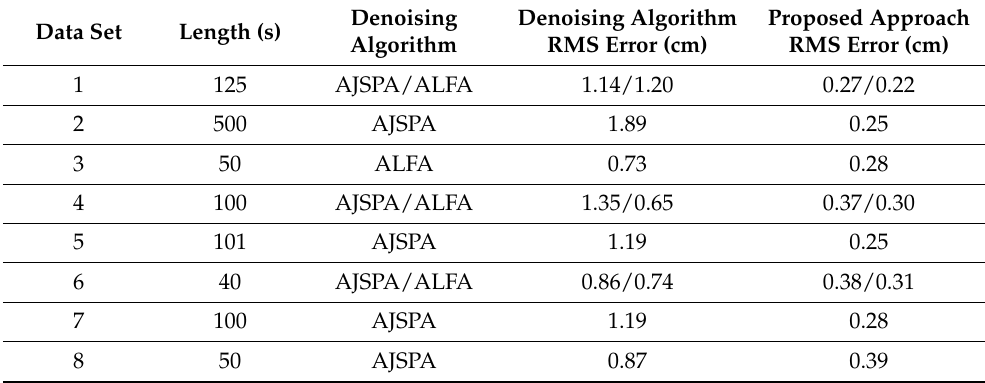
Table 1. Accuracy of the radar-based